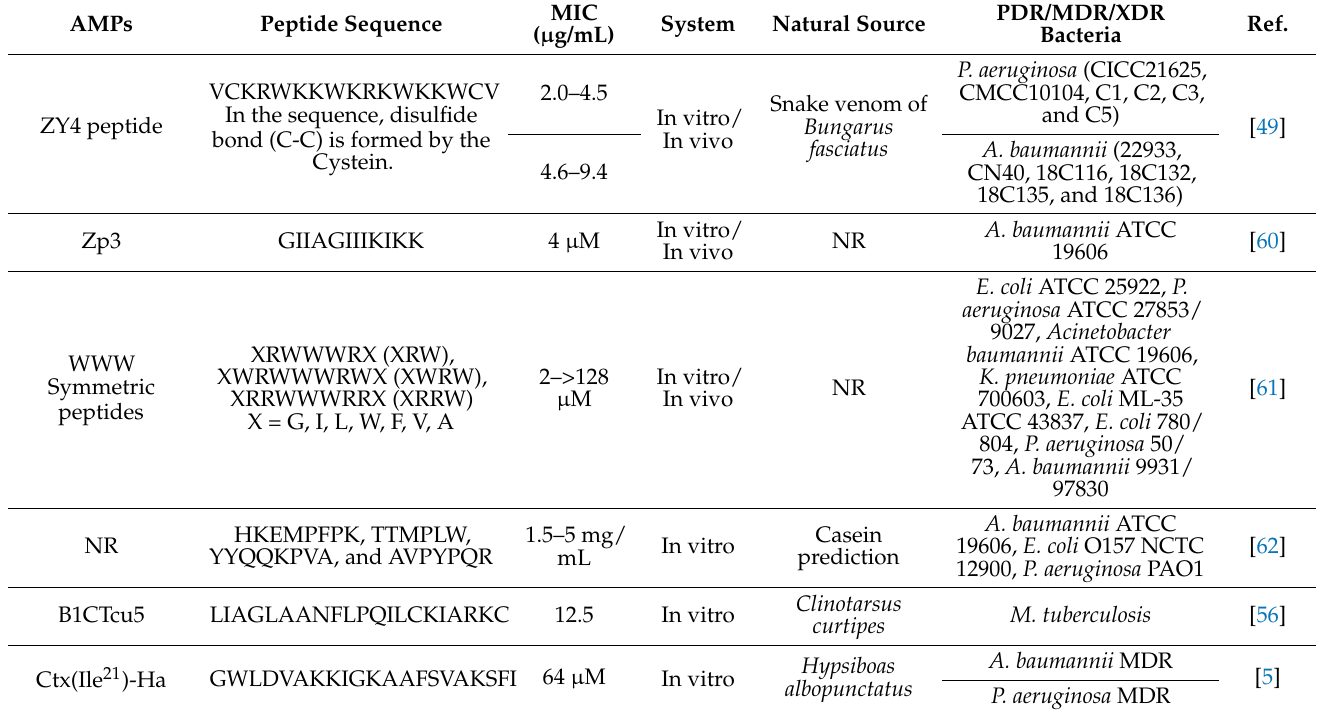
Table 3. Several reviews (2019 to 2021) of antimicrobial peptides applied against WHO-list (CPB). AMPs Peptide Sequence VCKRWKKWKRKWKKWCV In the sequence, disulfide bond (C-C) is formed by the